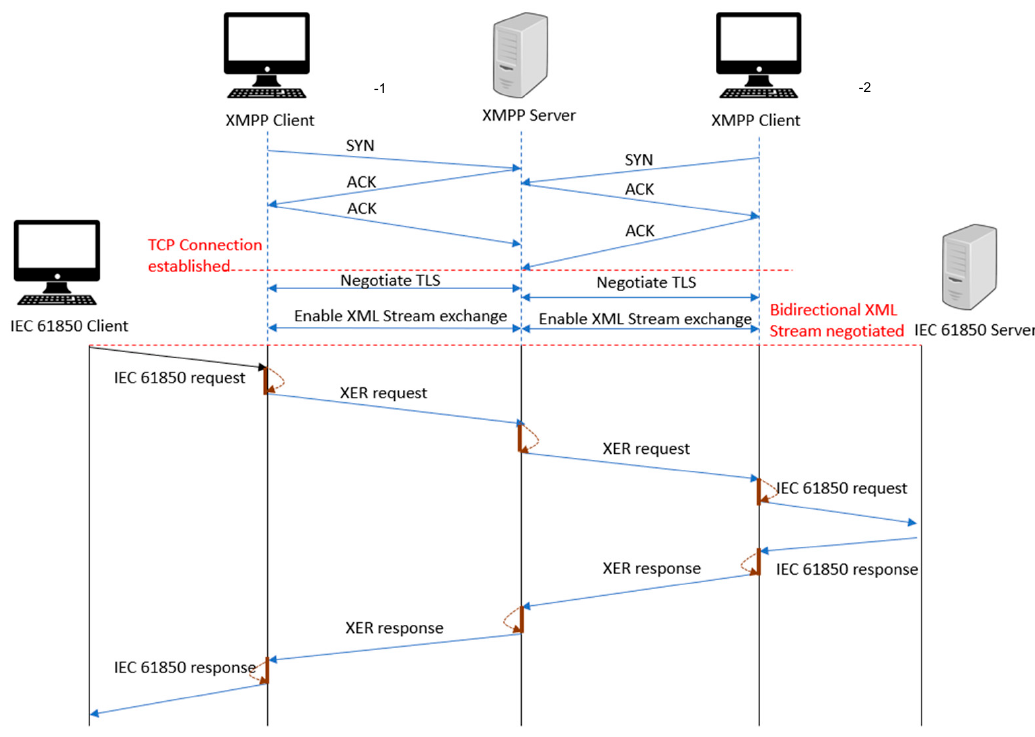
Figure 4. Communication flow sequence between XMPP clients.